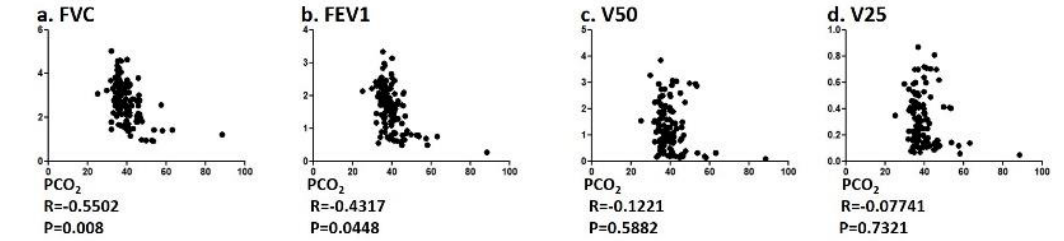
Figure 1. Correlation between PCO 2 and pulmonary function test values. Specifically, correlation between PCO 2 and ( a ) FVC, ( b ) FEV1, ( c ) V50, and ( d ) V25 were analyzed using Spearman rank correlation